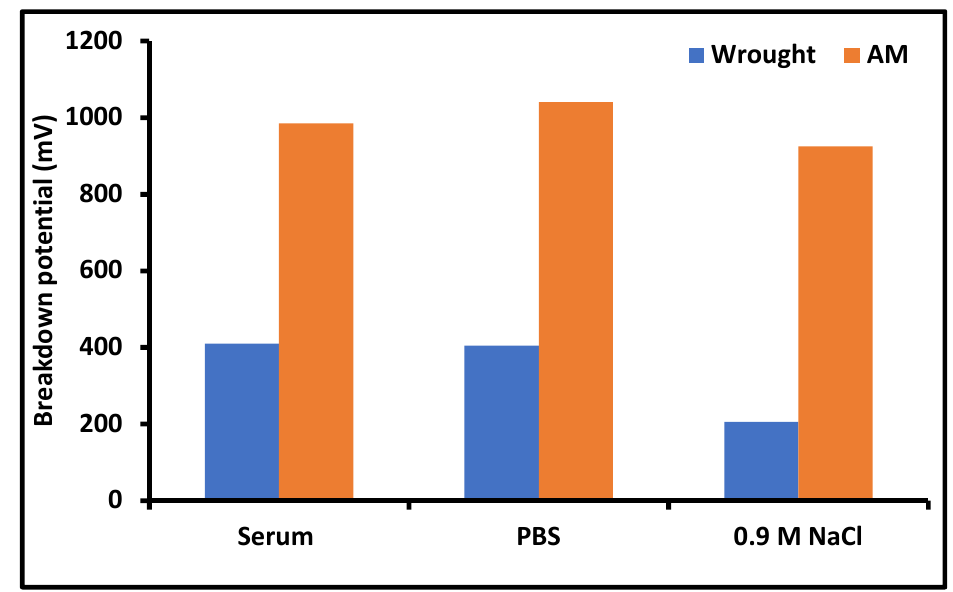
Figure 16. Breakdown potential in different environments of wrought and AM parts [54]. acidic environment for less than 3 pH values. The microstructure of wrought alloy vs. AM